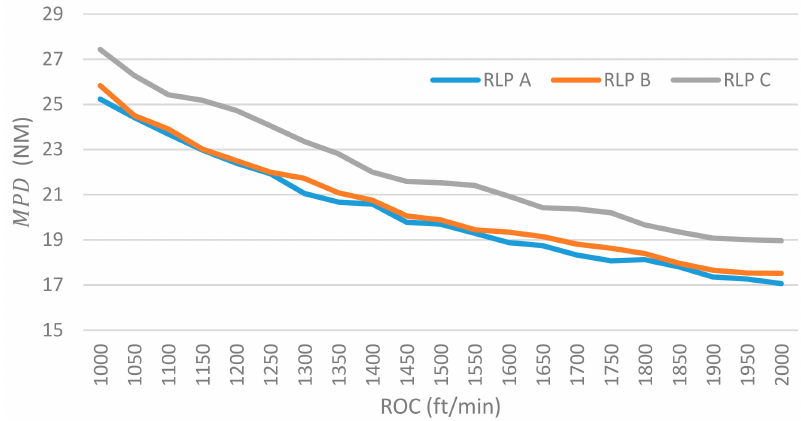
Figure 6. Variation of the minimum protection distance ( MPD ) as a function of RLP and rate of climb